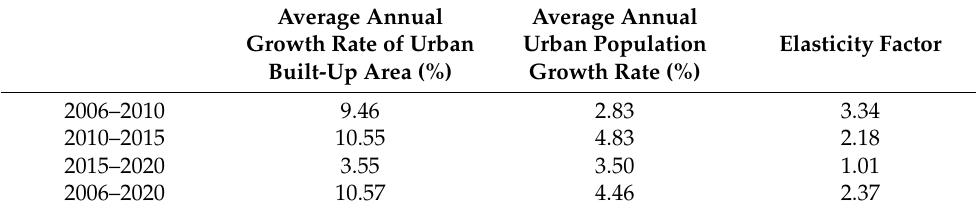
Table 11. Growth in urban built-up areas and urban population